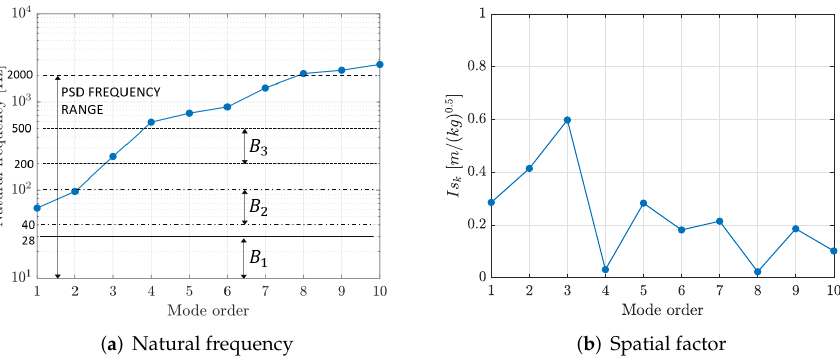
Figure 8. ( a ) Natural frequencies of the slat vs. mode order. The bands of the broad-band excitation from Figure 7 are highlighted. ( b ) Values of the geometric factors I S